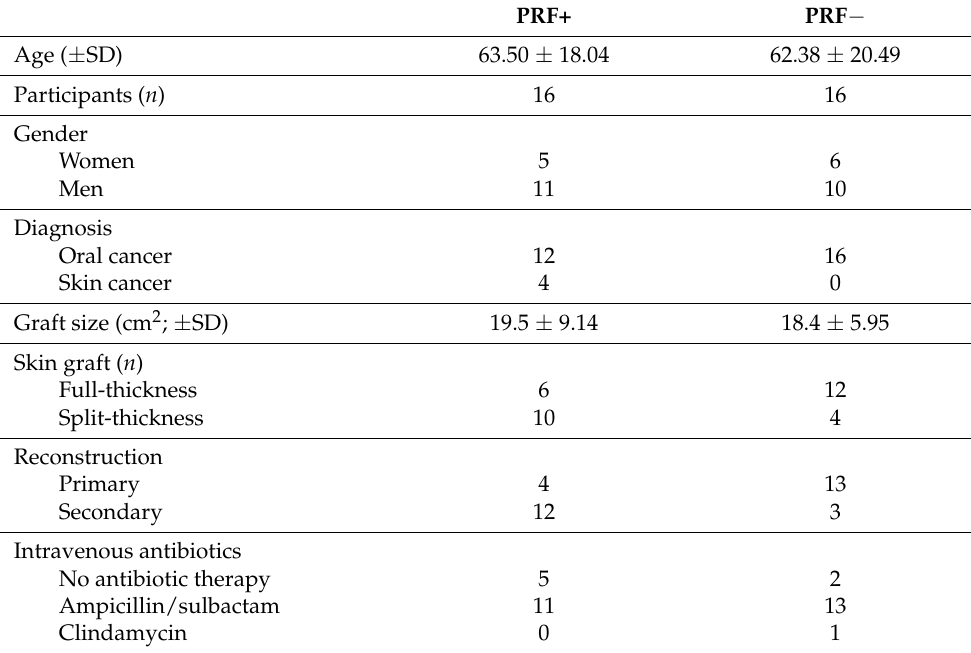
Table 2. Descriptive statistics.